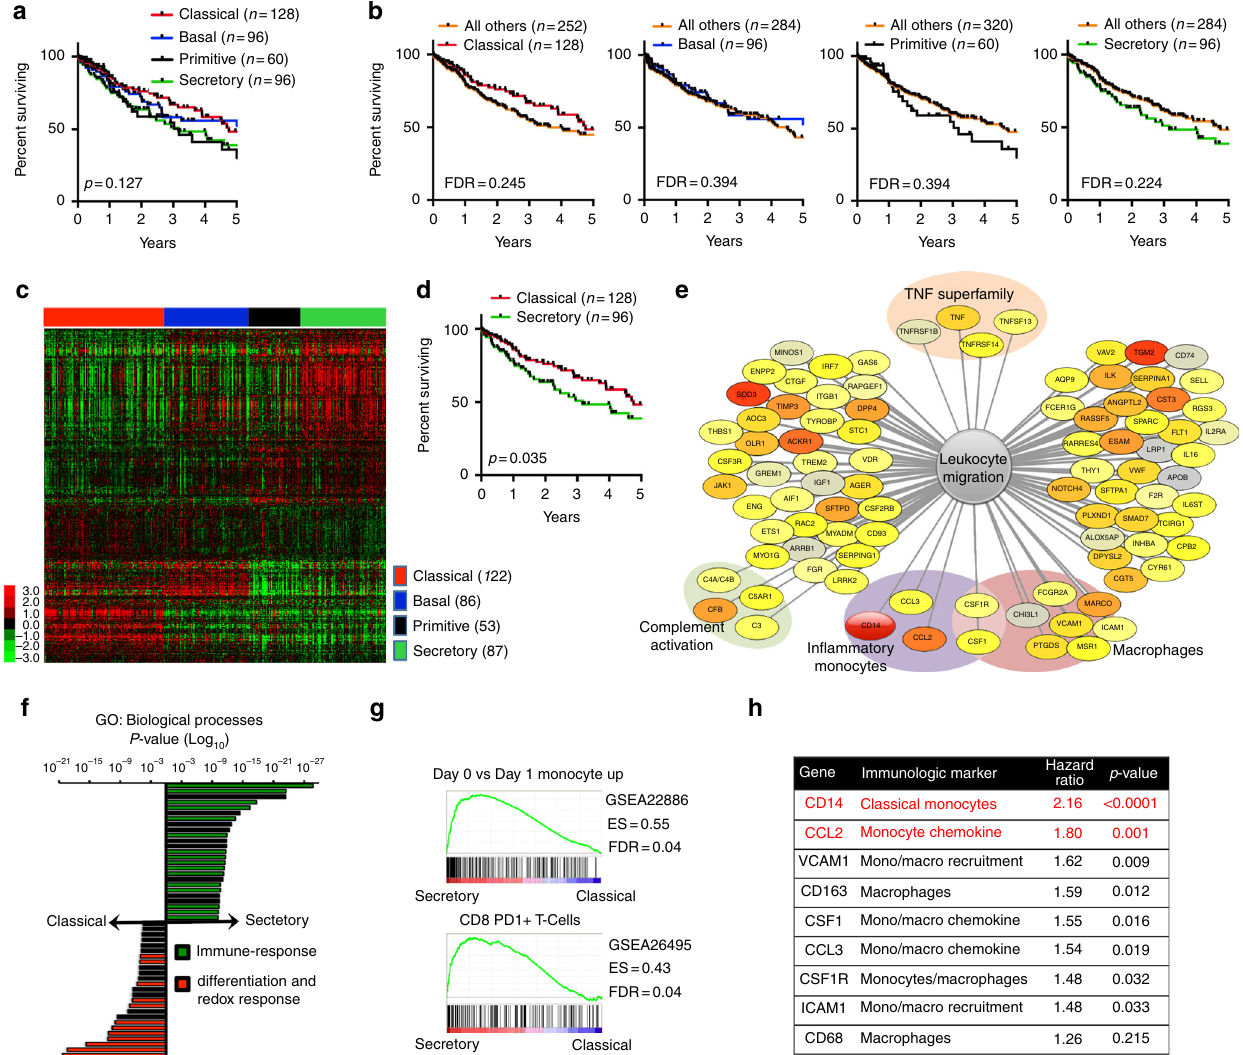
Fig. 1 Lung squamous carcinoma is associated with in fl ammatory monocytes. a Kaplan – Meier plots of overall survival in lung squamous carcinoma (LUSC) patients ( n = 380) from The Cancer Genome Atlas (TCGA) categorized by mRNA subtype. b Overall survival comparing each mRNA subtype with all others. c Hierarchical clustering of ( n = 4291) genes expressed in 348 patients from the LUSC TCGA RNA-seq dataset. d Overall survival comparing Classical versus Secretory subtypes. e Network visualization of Ingenuity Pathway Analysis (IPA) of all differentially expressed genes in the upper portion of the heat map (shown in panel c ) that are statistically signi fi cant ( p < 0.05) in terms of patient survival (in the comparison high ( ≥ median) vs. low ( < median) gene expression), termed “ survival genes ” . (Gray: least signi fi cant, Red: most signi fi cant) f . Gene ontology analysis to investigate the biological processes most linked with genes differentially expressed, moving between the Classical and Secretory subtypes (see the Supplementary Methods for details). Individual bars represent most statistically signi fi cant GO terms in either the Classical (red bars) or Secretory (green bars) subtype. g Gene Set Enrichment Analyses (GSEA) of the LUSC TCGA dataset. The GSEA is performed going from Secretory to Classical; the GSEA ‘ mountain plots ’ show only the two most divergent subtypes. Gene set names were shortened to fi t this fi gure. h Table showing 9 genes from the upper portion of the heat map that are associated with reduced overall survival and are markers of monocytes and macrophages. Genes with log-rank p ≤ 0.001 are highlighted in